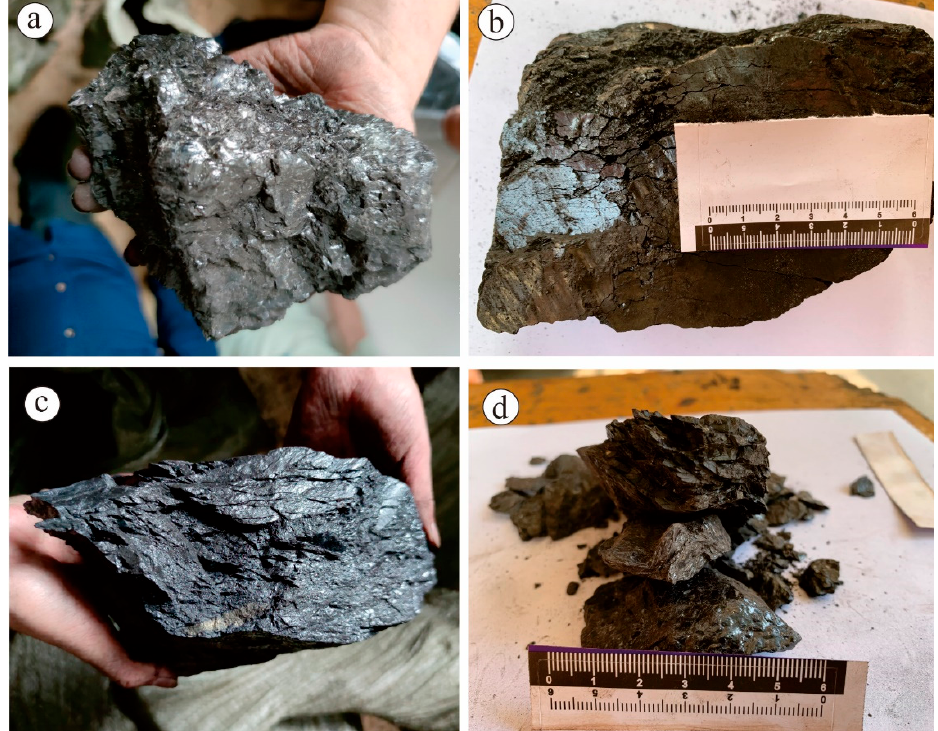
Figure 5. Main tectonically deformed coal types of thick coal (11#) in Dahebian Block. ( a ) Schistose coal (2 m below the roof); ( b ) Granulated coal (2.5 m below the roof); ( c ) Cataclastic coal/lenticular coal (0.5 m above the floor); and ( d ) Schistose coal with a small fold (1.5 m above the